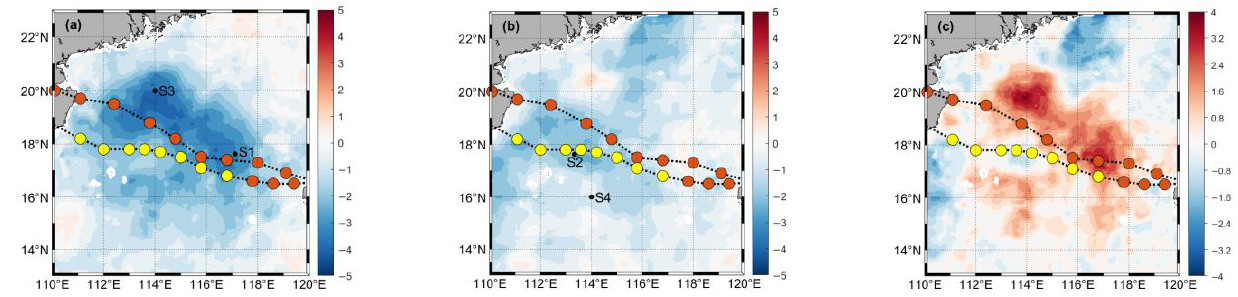
Figure 4. ( a ) The decrease in SST caused by Nesat; ( b ) the decrease in SST caused by Nalgae; ( c ) the difference. In the decrease in SST caused by the two typhoons. The positions of the dots represent the positions of selected feature points, which are discussed in Sections 4.2 and 4.3, where S1 represents the daily maximum temperature decrease of Nesat and S2 represents the daily maximum temperature decrease of Nalgae. (The discs represent the locations of the typhoons and the color of each disc represents the intensity of the typhoons, following the color categorization in Figure 2a).